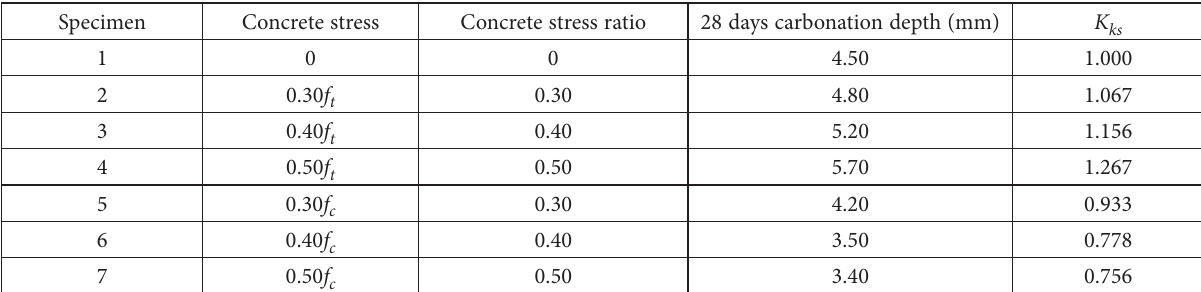
Table 9. Carbonation depths of specimens under different concrete stress conditions (data from Zhang et al., 2017) Specimen